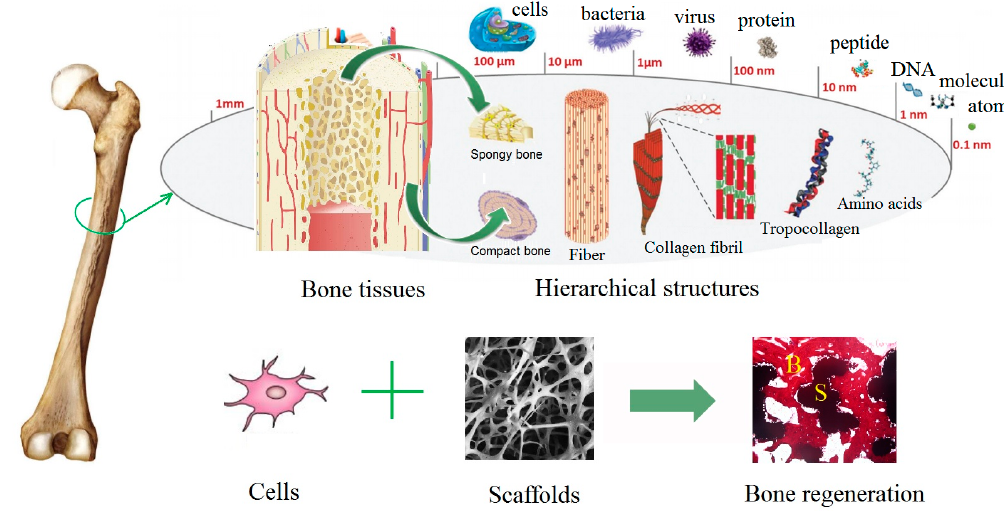
Figure 1. The hierarchical anatomy structures of bone tissues. Bone regeneration strategy is conducted by the synergistic effect of cells and scaffolds.